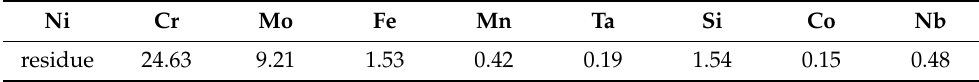
Table 1. Chemical composition of the Heraenium ® NA alloy (wt.%).